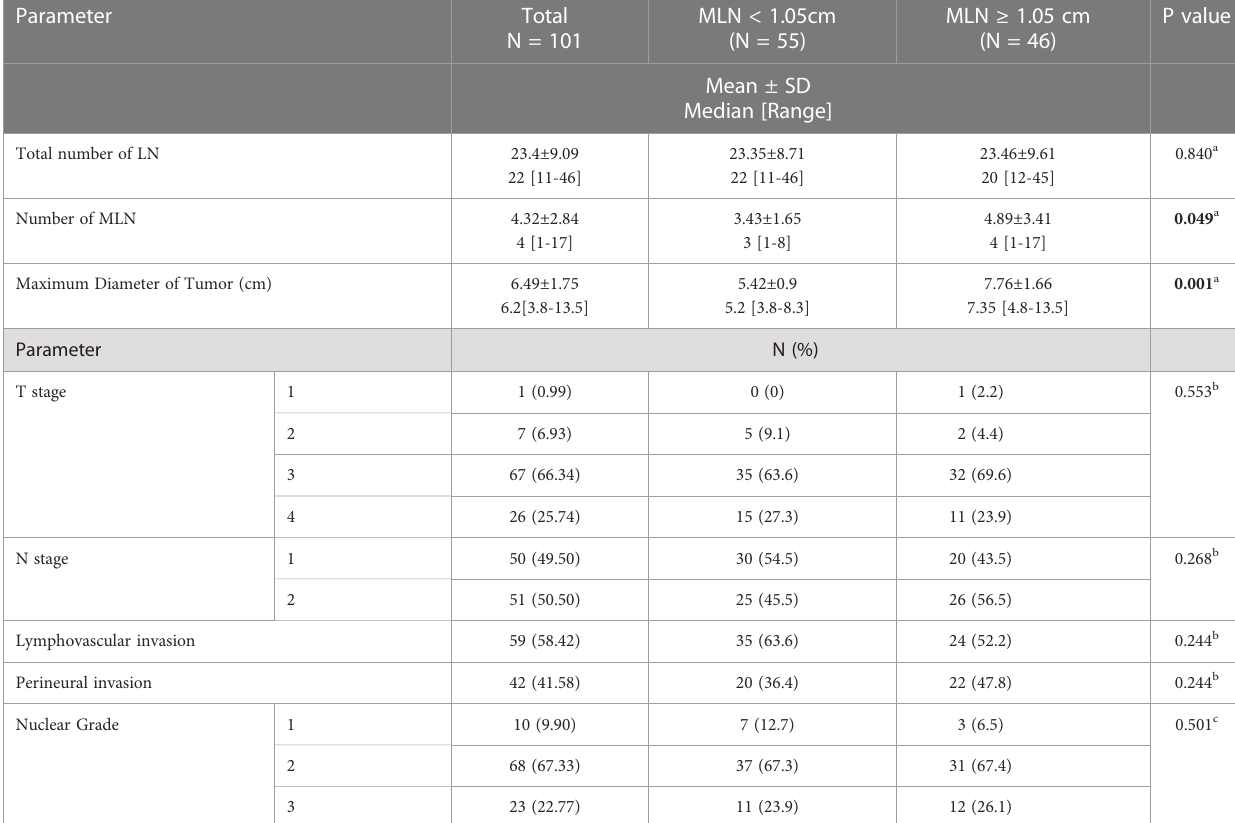
TABLE 8 Histopathological fi